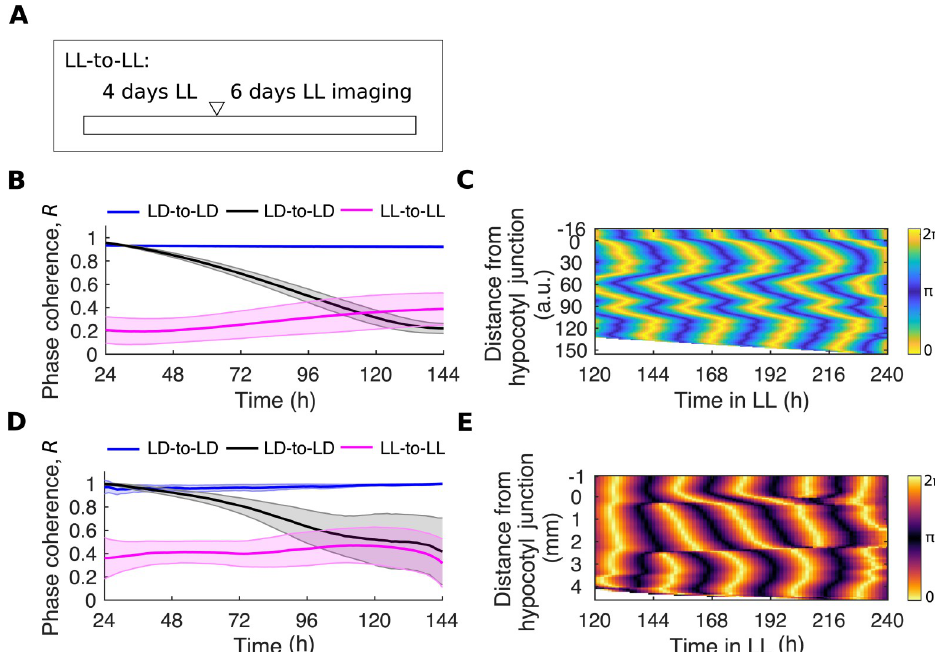
Fig 5. Local coupling limits desynchrony in the absence of LD cycles. (A) Schematic depicting the experimental conditions used. Seedlings were grown for 4 d under LL and then imaged, also under LL (LL-to-LL), so that seedlings have never seen an LD cycle. The white triangle represents the beginning of imaging. (B) Quantification of phase coherence by time evolution of the Kuramoto order parameter, R , for simulated GI expression. Solid lines indicate the mean and the shaded region one standard deviation of the mean. (C) Representative phase plot of simulated GI expression across longitudinal sections of the hypocotyl and root of a single seedling under the LL-to-LL condition. (D) Quantification of phase coherence by time evolution of the Kuramoto order parameter, R , for GI :: LUC expression. Solid lines indicate the mean and the shaded region one standard deviation of the mean. (E) Representative phase plot of GI :: LUC expression across longitudinal sections of the hypocotyl and root of a single seedling under the LL-to-LL condition. For LL-to-LL GI :: LUC data, N = 3 and n = 30; for GI model simulations, n = 24. N represents the number of independent experiments and n the total number of organs tracked. See S2 File for exact n , test statistics, and percentage rhythmicity in each organ. Underlying data are available from https://gitlab.com/slcu/teamJL/greenwood_ etal_2019. a.u., arbitrary unit; GI , GIGANTEA ; LD, light-dark; LL, constant light; LUC , LUCIFERASE .